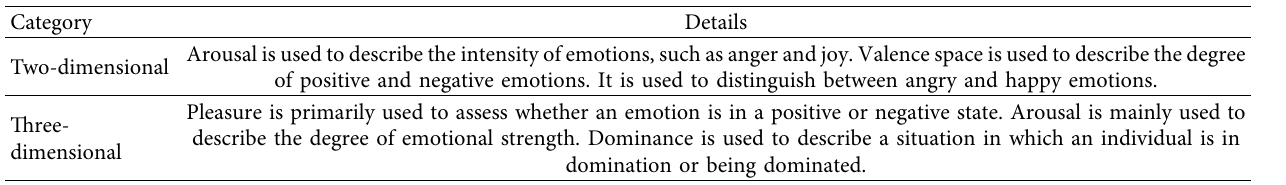
Table 2: Details of continuous emotion division.